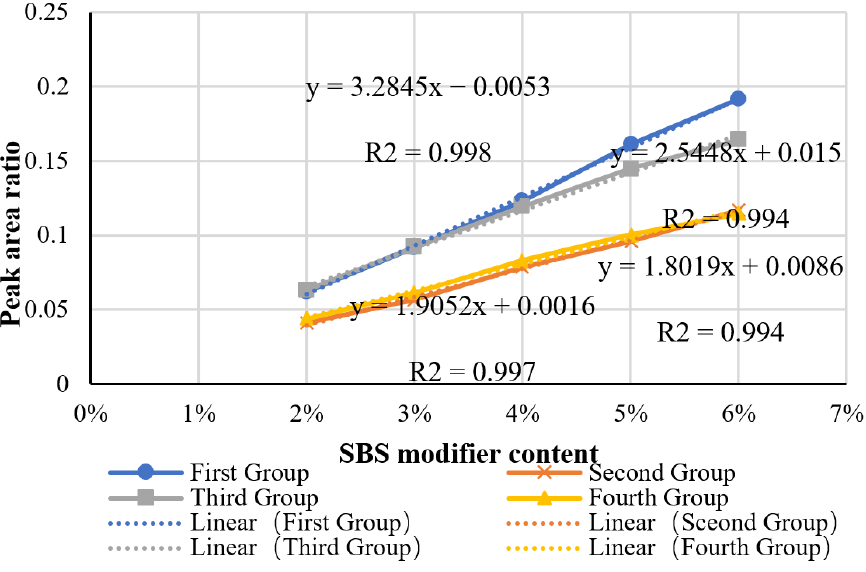
Figure 4. SBS standard curve model.